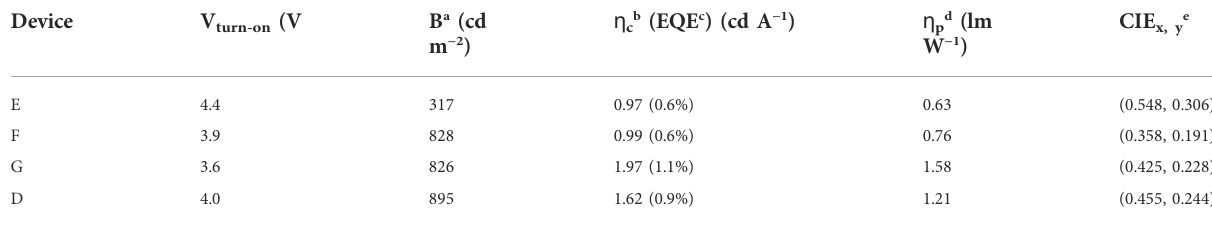
TABLE 2 The key properties of devices E, F, G, and D. Device